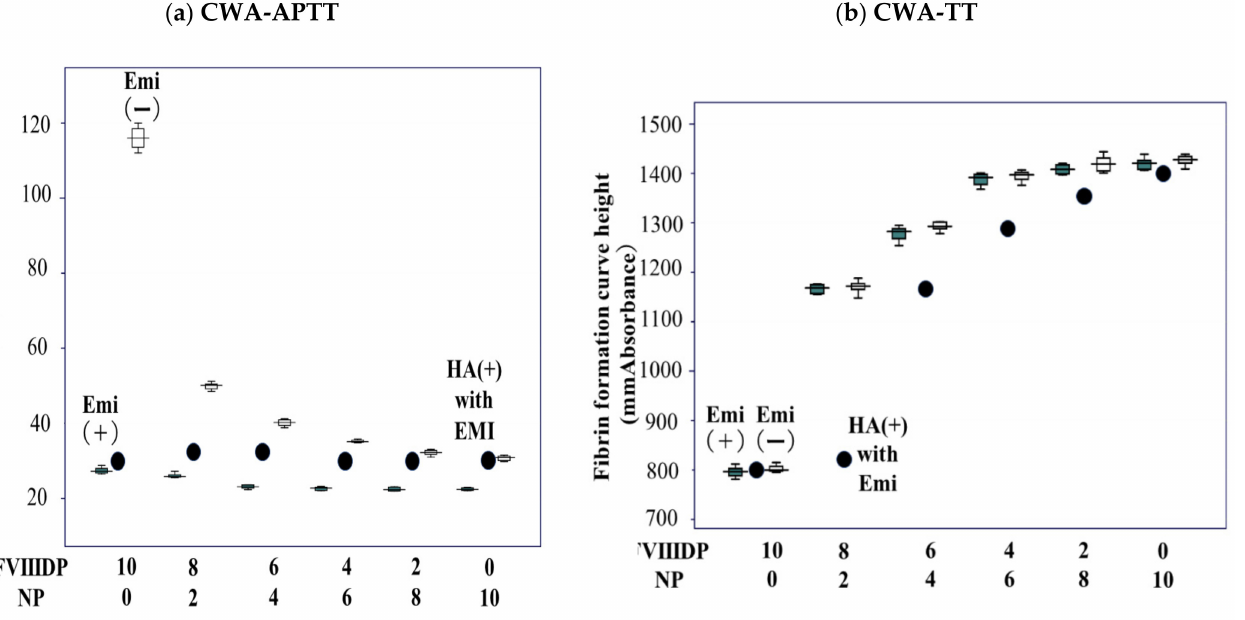
Figure 4. Mixing test of normal and FVIII-deficient plasma with and without emicizumab using the clot wave analysis (CWA) of the second DPT of activated partial thromboplastin time (APTT) ( a ) or fibrin formation curve height at 500 s of thrombin time (TT) ( b ). DPT, derivative peak time; FVIIIDP, FVIII-deficient plasma; NP, normal plasma; Emi (+), with emicizumab; Emi ( − ), without emicizumab. HA (+) with EMI ( • ), hemophilia A patient with inhibitor treated with emicizumab. All assays were performed more than three times to confirm the